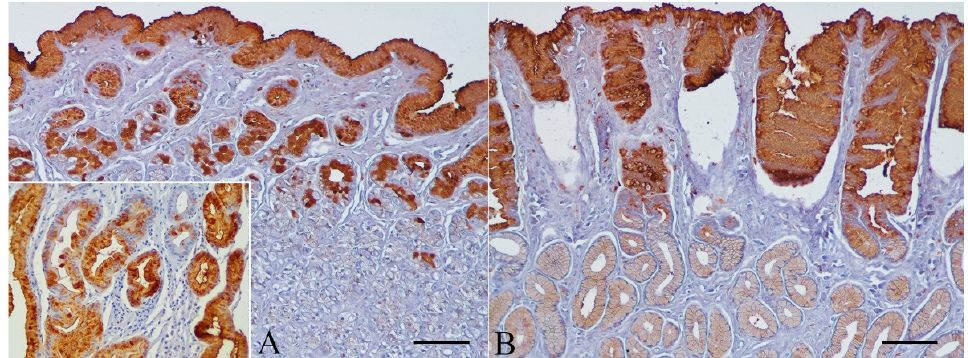
Figure 2. Normal canine gastric mucosa. Immunohistochemistry for TFF1 counterstained with Mayer ´ s hematoxylin. Strong, diffuse, and cytoplasmic TFF1 expression in superficial foveolar epithelium and mucopeptic cells of the neck region from the gastric body ( A ) and pyloric antrum ( B ). Note the absence of staining in body glands ( A ) and the decrease in labeling intensity in the antral glands ( B ) (bar = 100 μ m). Inset shows diffuse cytoplasmic TFF1 immunostaining in superficial foveolar epithelium and in the foci of IM of the human gastric mucosa (positive control; 200×).